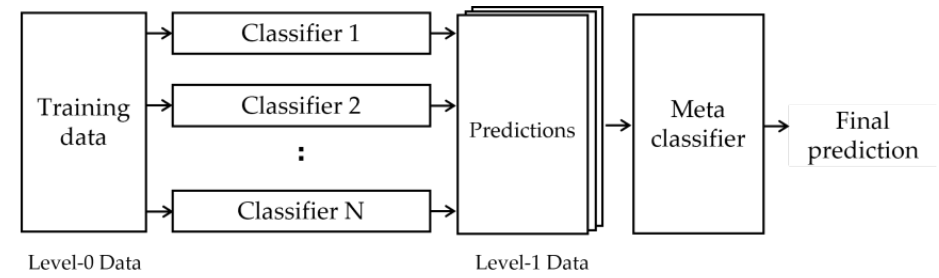
Figure 7. Simple scheme of stacking ensemble learning